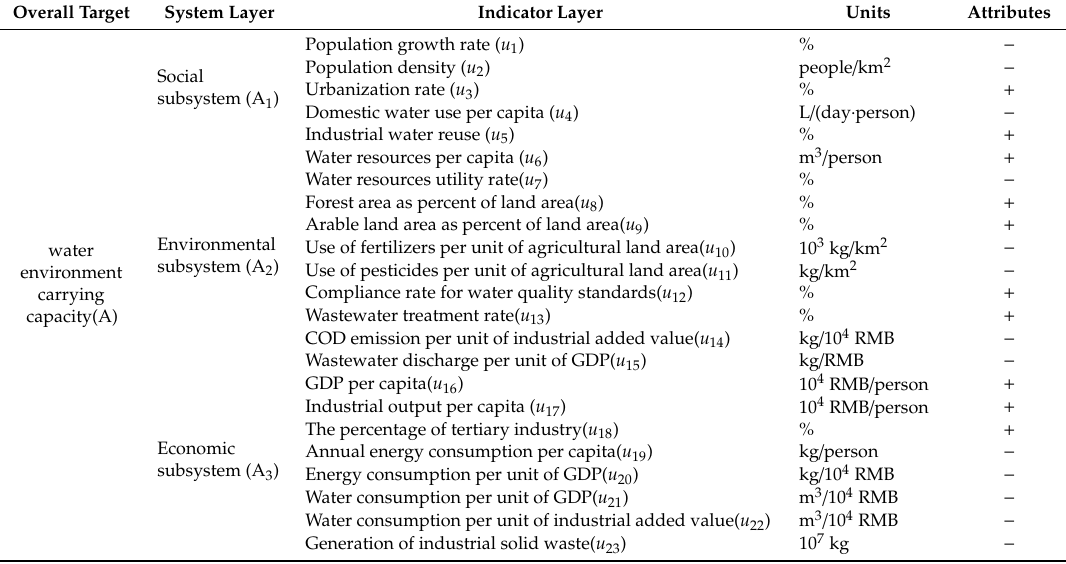
Table 1. Evaluation indicator system of water environment carrying capacity